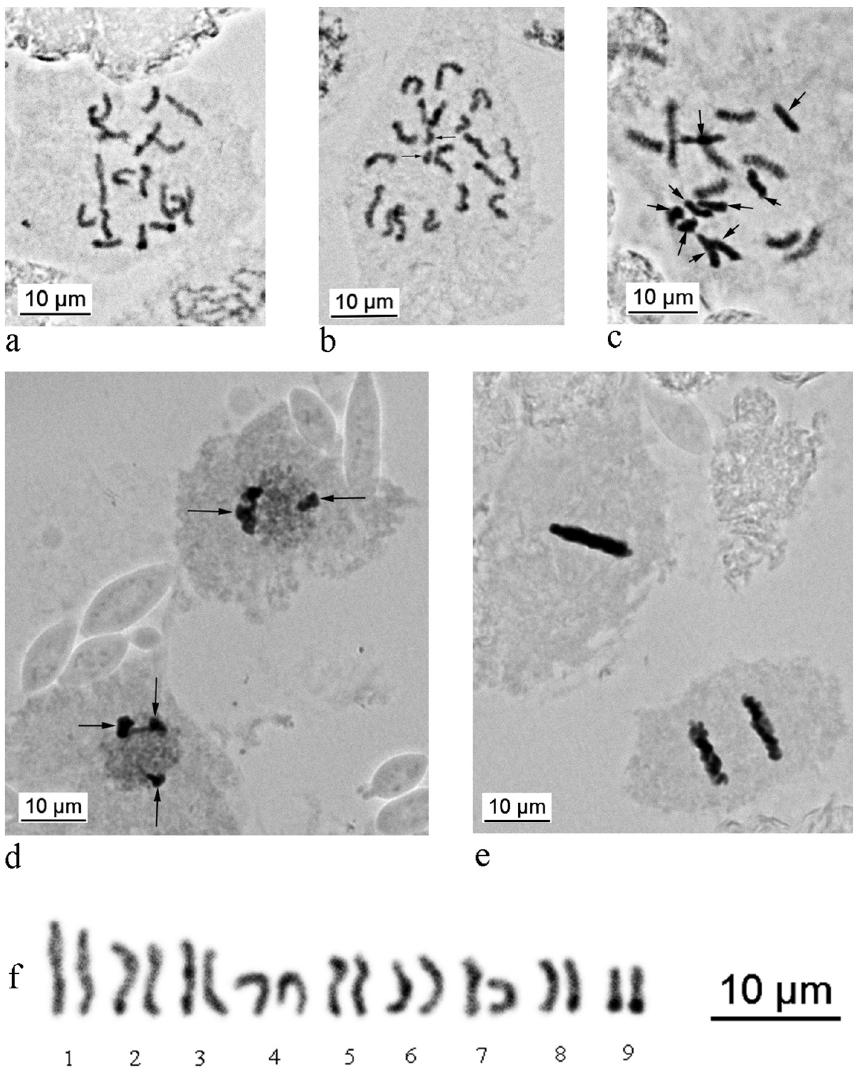
Figure 2. Embryonic cells of Psoraleococcus multipori . a female embryo, 2n = 18 b female embryo, 2n = 18 + 2B (B-chromosomes arrowed) c male embryo, paternal set of chromosomes begins heterochromati- nization (arrowed) d Lecanoid heterochromatinization (arrowed) in interphase cells of male embryo; e metaphase and anaphase in female embryo showing no lagging chromosomes (Bs) f karyogram, prepared basing on the Fig.